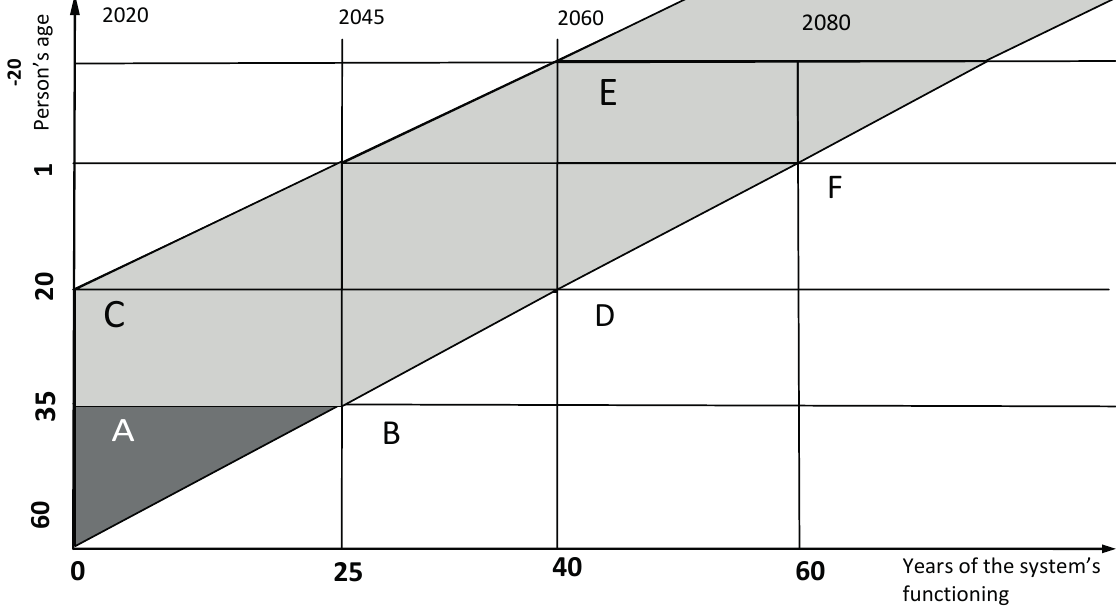
Figure 2. The scheme of accumulation of funds by the accumulative pension insurance